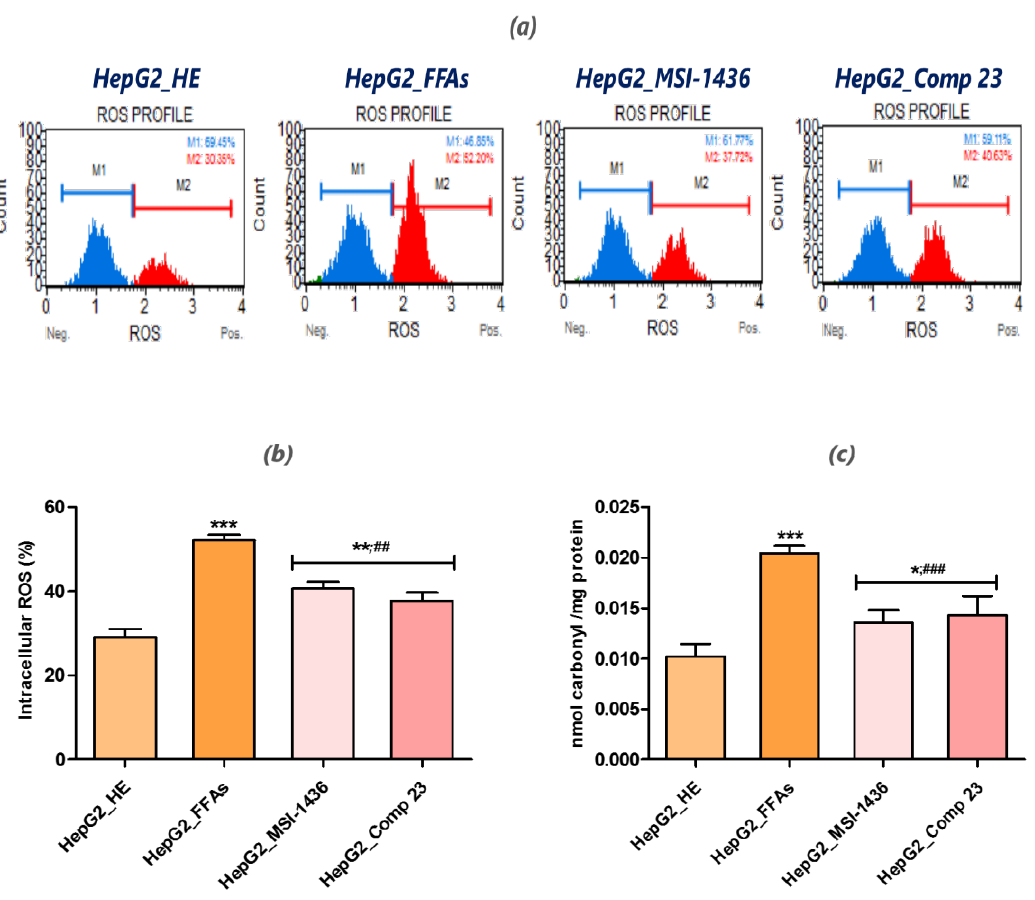
Figure 5. Effects of MSI-1436 and compound 23 on the palmitate/oleate-induced reactive oxygen species (ROS) production and protein carbonylation in HepG2 cells. ( a ) Representative plots depicting cells stained with DHE evaluated using a flow cytometer. ( b ) Bar charts summarize the mean percentage ± SD of total intracellular ROS positive cells. ( c ) Graphical representation of the total protein carbonyl group content variation in the different tested groups. Representative data from three independent experiments are shown as mean ± SD ( n = 3). An asterisk (*) indicates a comparison of all treated groups to untreated healthy cells. A hashtag (#) indicates a comparison of the PTP inhibitor treated groups to FFA-challenged cells. */#, p < 0.05, **/##, p < 0.01, ***/###, p < 0.001.